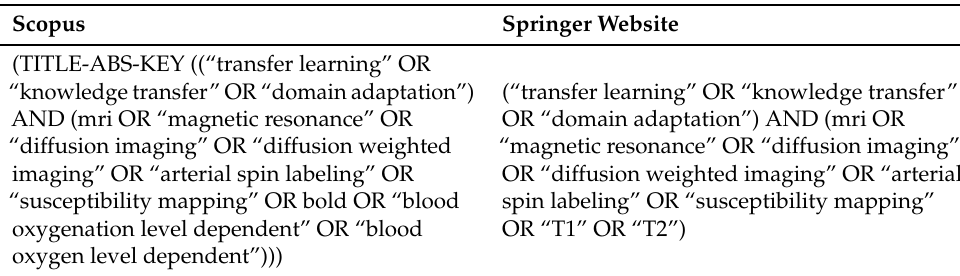
Table 2. Search terms in Scopus and